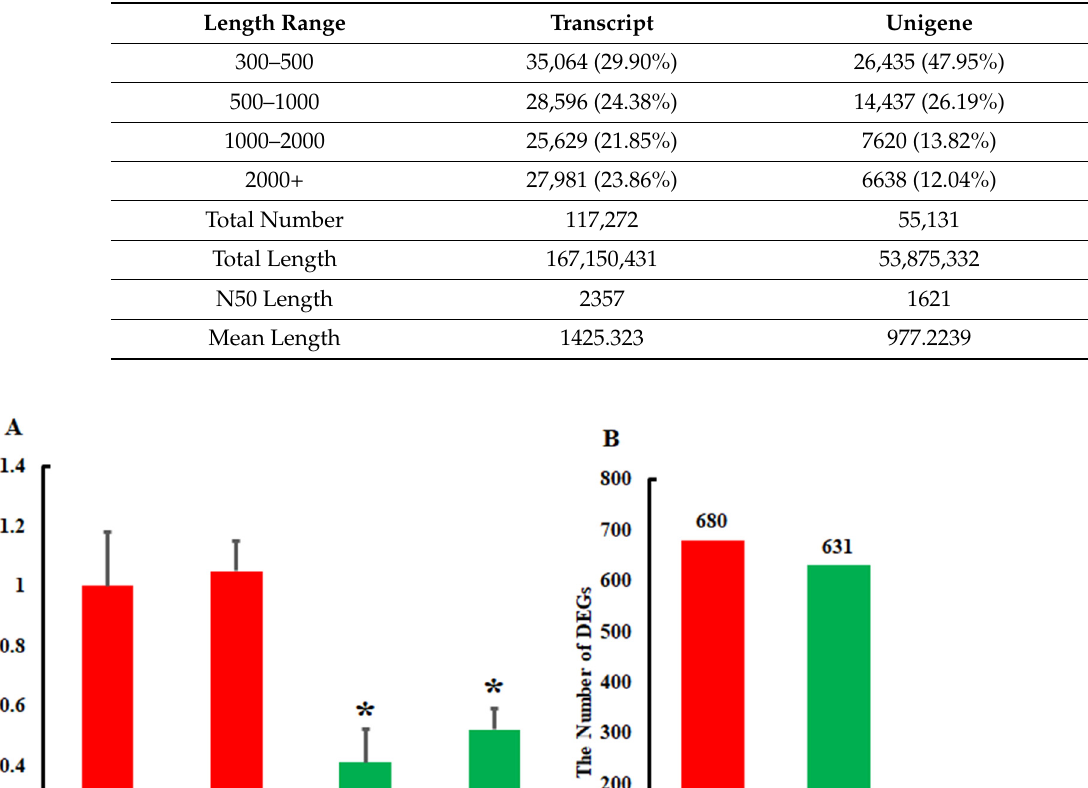
Table 2. Distribution of splicing length.